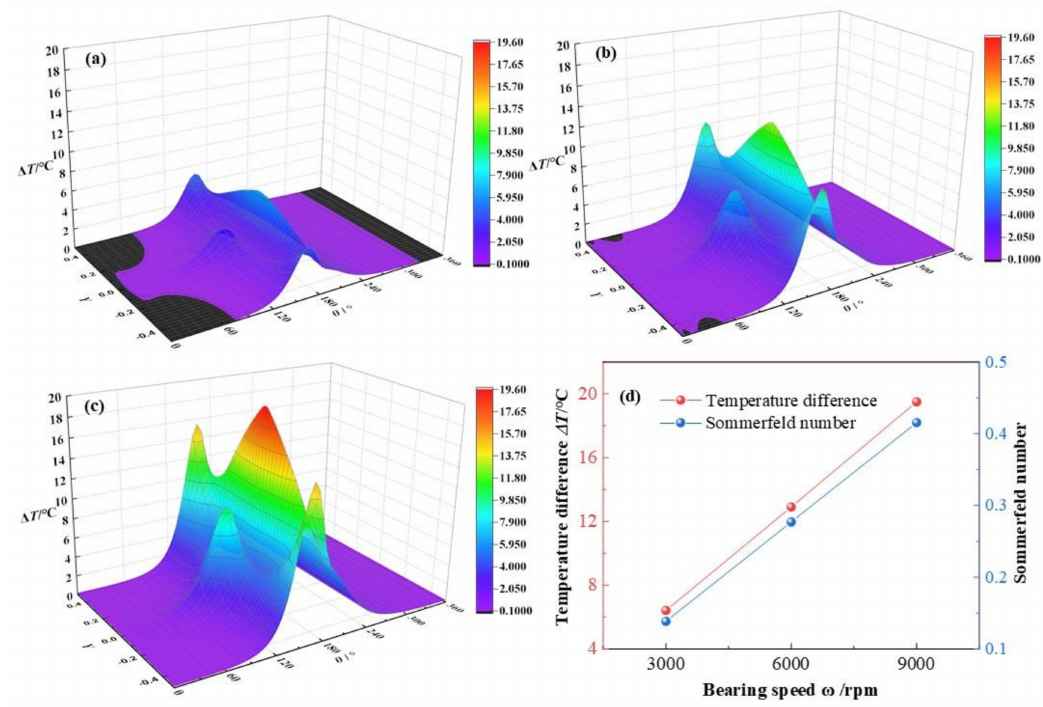
Figure 17. Comparison of the temperature distribution under different bearing speeds. ( a ) ω = 3 × 10 3 rpm; ( b ) ω = 6 × 10 3 rpm; ( c ) ω = 9 × 10 3 rpm; ( d ) maximum